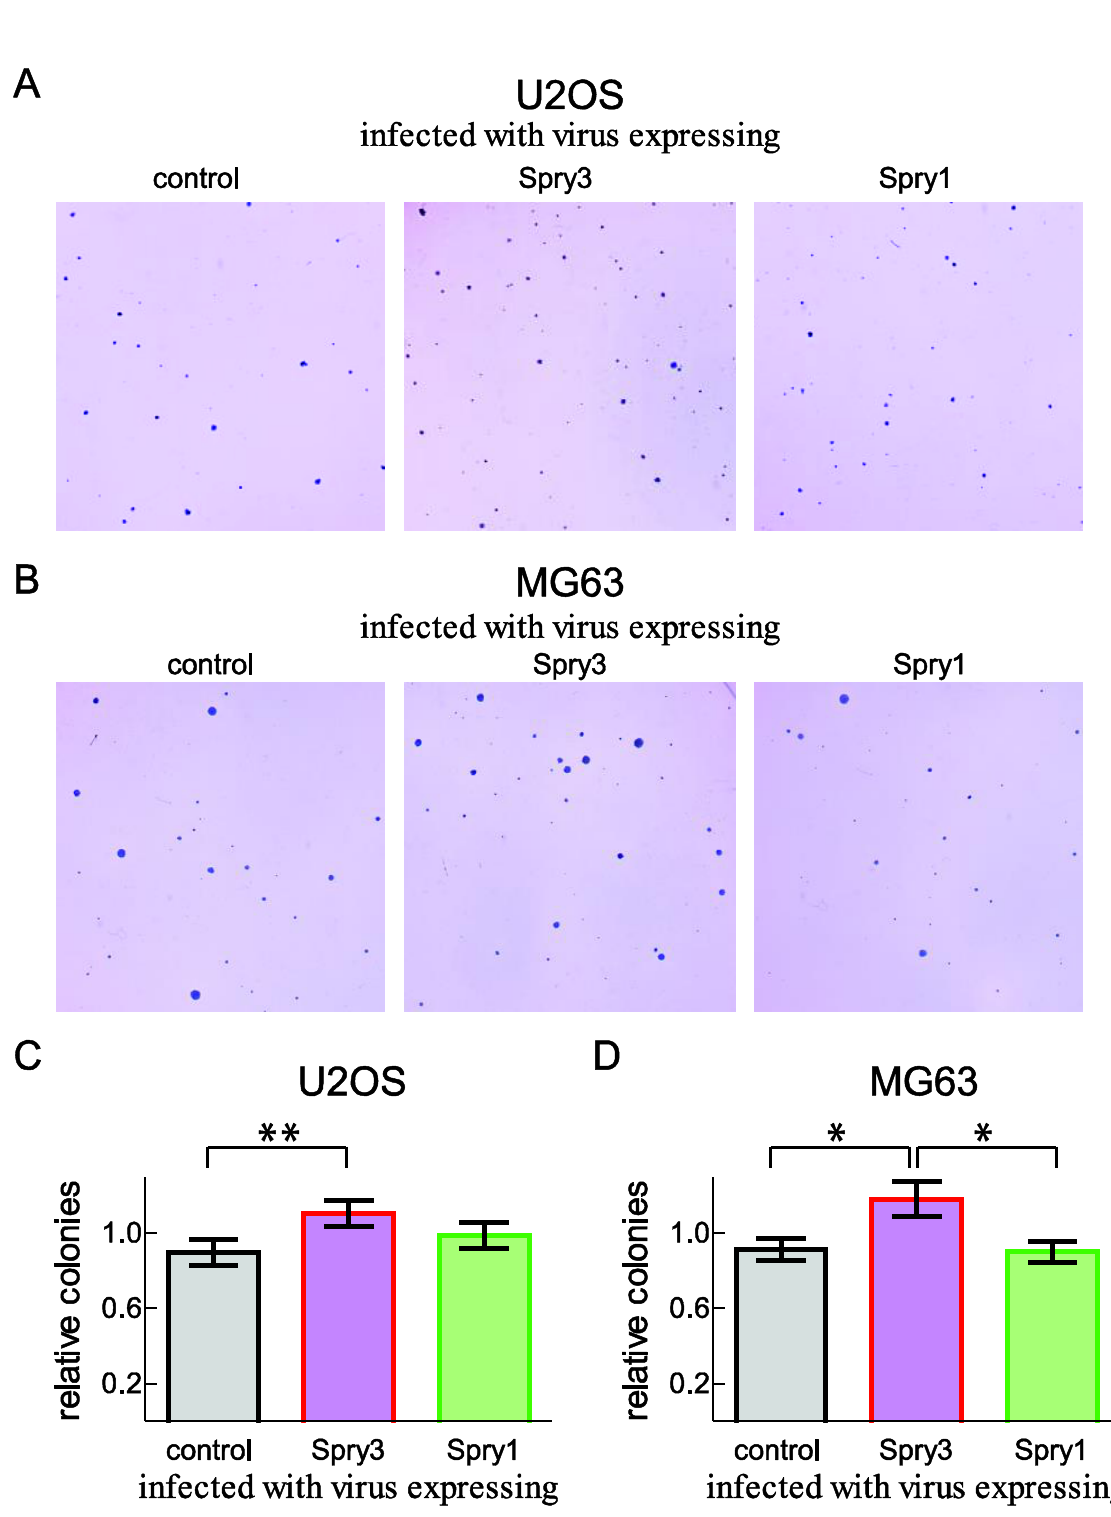
Figure 5. Influence of Spry3 and Spry1 expression on the ability of osteosarcoma-derived cells to form colonies in a semisolid medium. U2OS ( A ) and MG63 ( B ) cells were infected with adenoviruses expressing the indicated proteins. A representative section of a Soft agar plate is depicted. The U2OS ( C ) and MG63 ( D ) cell clones were counted and evaluated. To adjust the experimental variations, the obtained numbers of each experiment are given as the ratio to the experimental mean. Significance was assessed using an unpaired t-test in GraphPad Prism and means ± SEM are shown. ** p < 0.01; * p < 0.05.